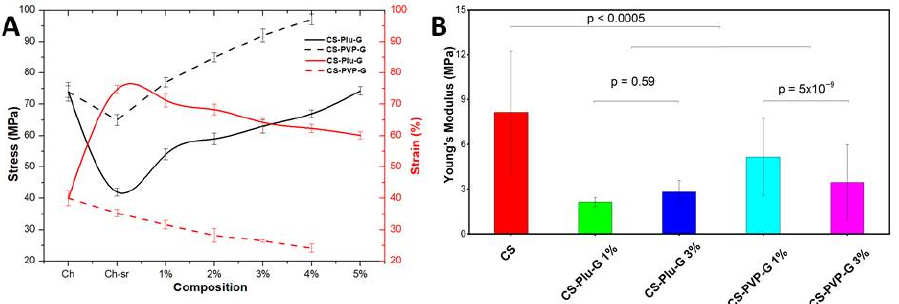
Figure 4. ( A ) Uniaxial tensile tests of CS, CS-PVP, CS-Plu and graphene-containing composite films. ( B ) Mechanical properties of CS/graphene composite films measured via nanoindentation. ( B ) Mechanical properties of CS/graphene composite films measured via